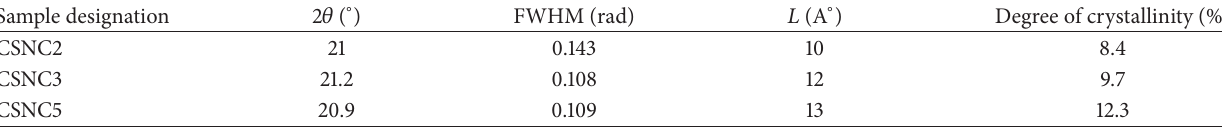
Table 2: 2𝜃 ∘ , FWHM, crystallite size ( 𝐿 ), and degree of crystallinity ( 𝜒 ) for CSNC2, CSNC3, and CSNC5